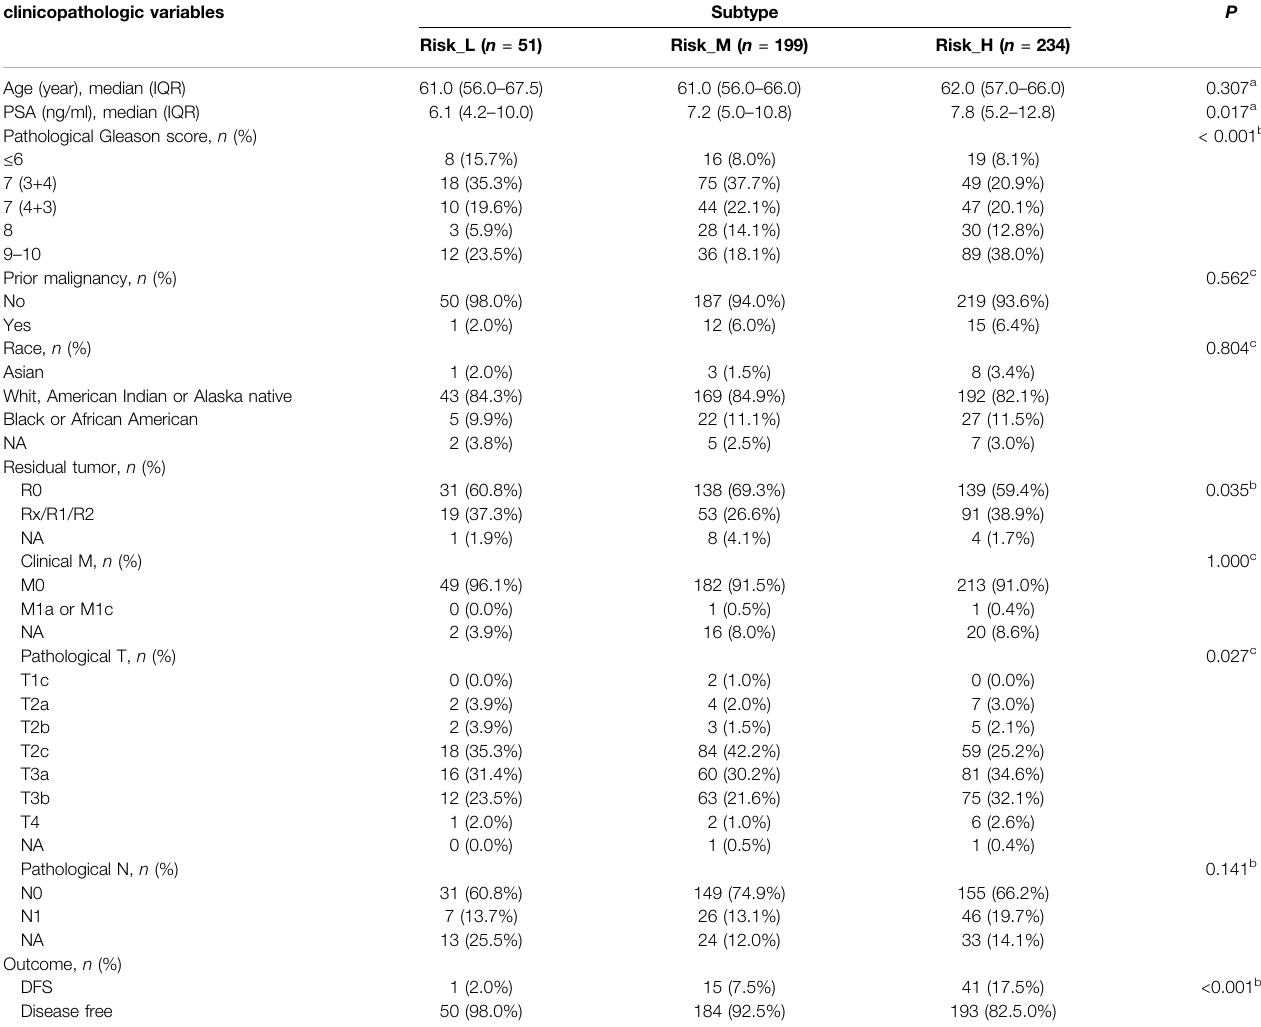
TABLE 2 | The association between subtypes and clinicopathologic variables of prostate cancer. clinicopathologic